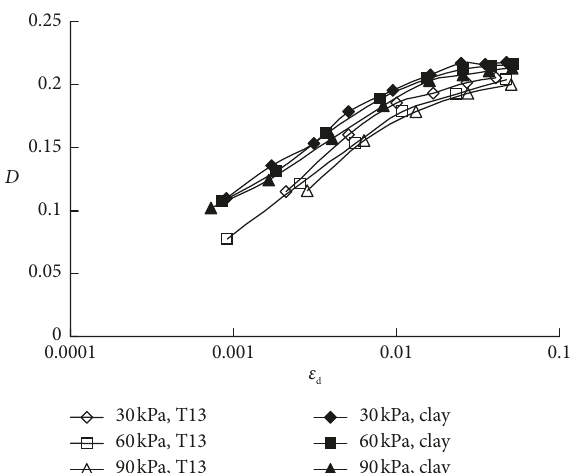
Figure 14: Relationship between the damping ratio and dynamic strain of LCES and clay under different confining